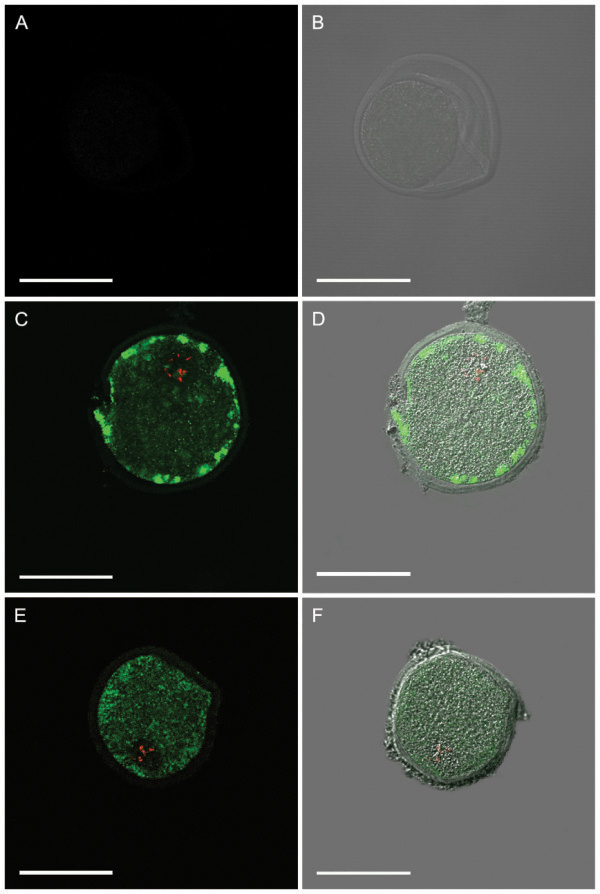
Expression of GM-CSF α and β receptors in bovine COC. Confocal microscopy analysis was performed using anti-GM-CSFrα and anti-GM-CSFrβ antibodies. (A, B) Specimen incubated without the first (primary) antibody showed no signal. C, D: GM-CSFrα subunit (green). E, F: GM-CSFrβ subunit (green). Oocyte nuclei were stained using propidum iodide (red). Scale bar = 100 μm.